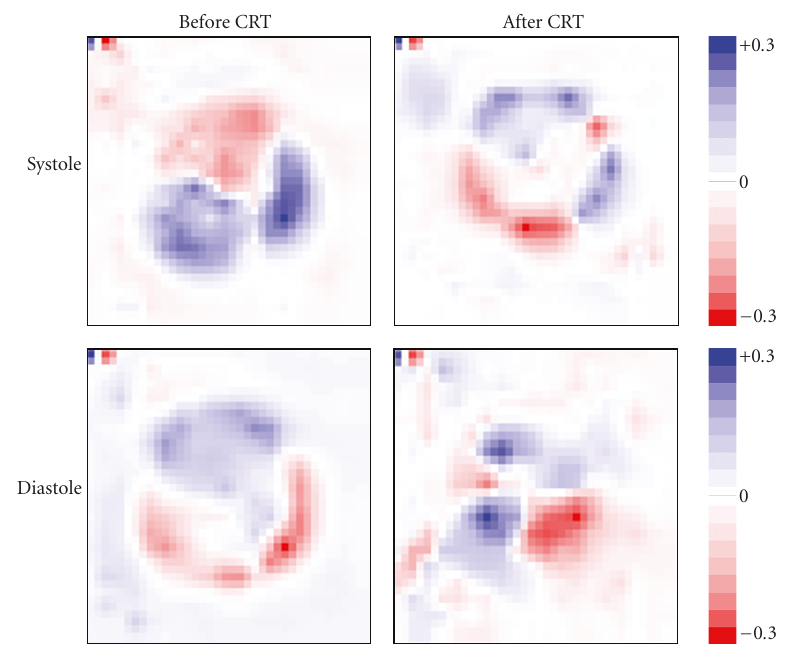
Figure 6: Horizontal motion of a Group1 patient. A slice from the midcavity is shown in systole and diastole, and before and after CRT. A movement pattern similar to the normal is seen after CRT in both systole and diastole. The color scale is shown at the top right of the